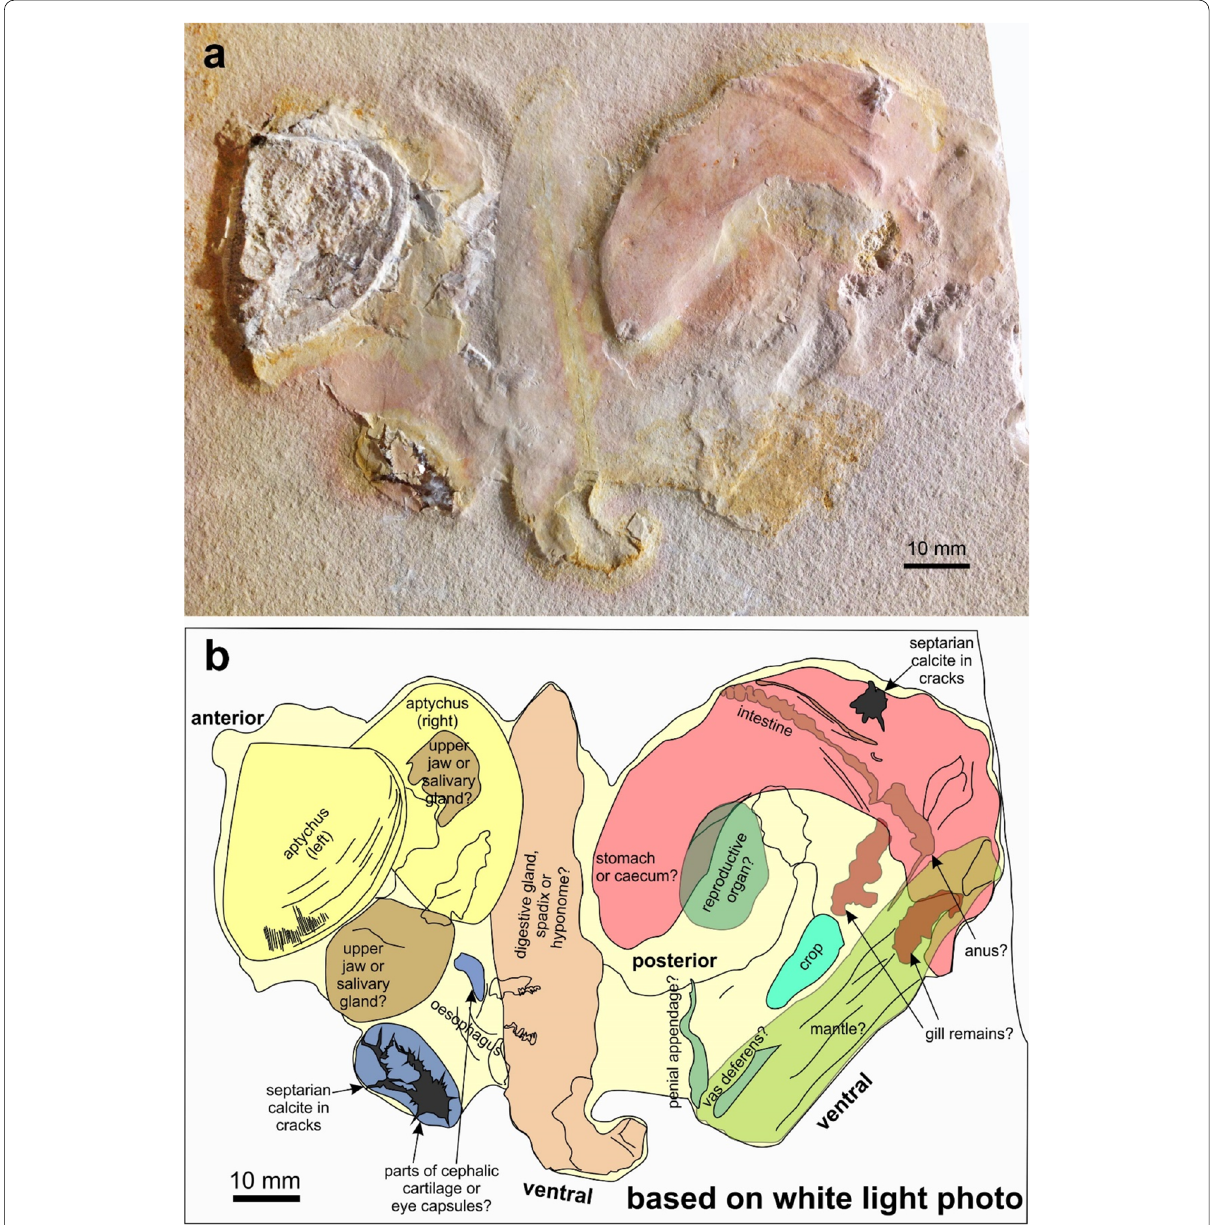
Fig. 1 Soft parts of Subplanites sp. with a Strigogranulaptychus sp. from the early Tithonian of Wintershof near Eichstätt (Germany); SMNS 70,610. a Photo taken under white light. b Line drawing of the structures visible in the white light‑photo ( a ) with possible